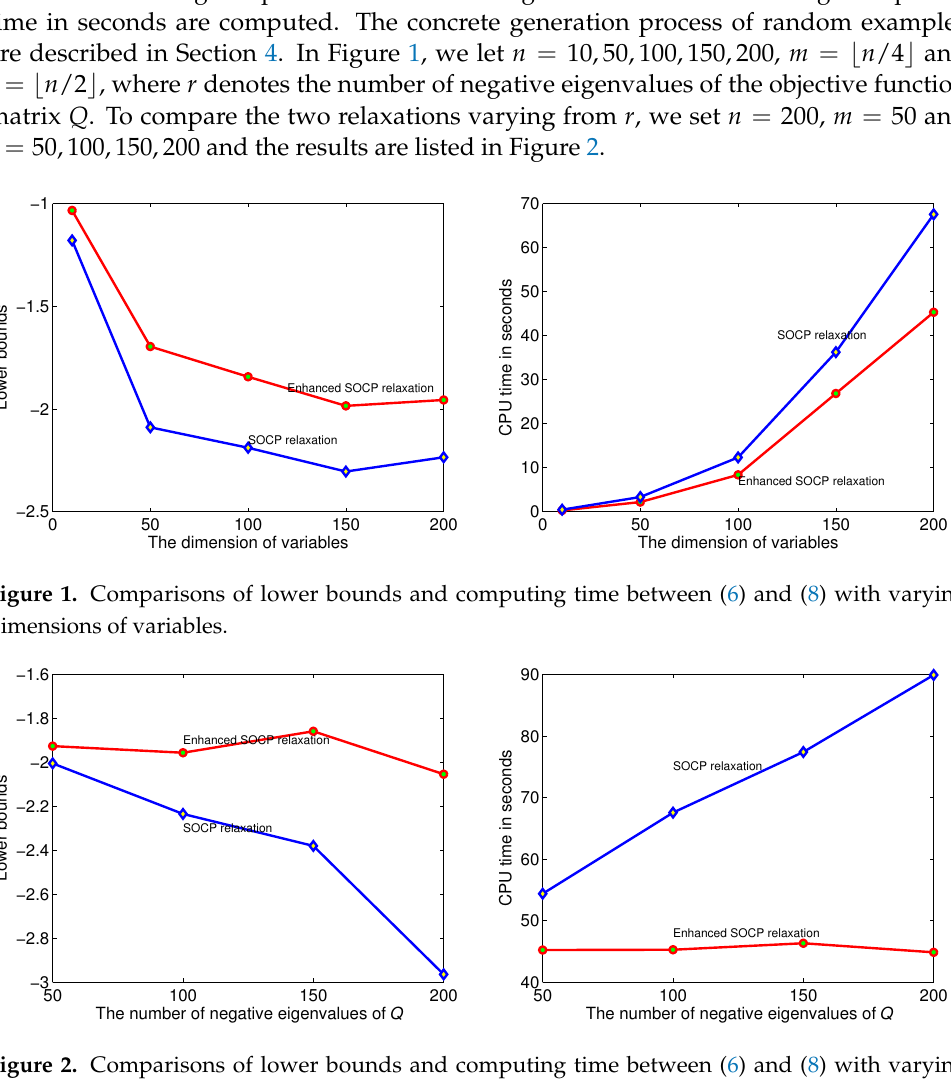
Figure 2. Comparisons of lower bounds and computing time between (6) and (8) with varying numbers of negative eigenvalues of Q